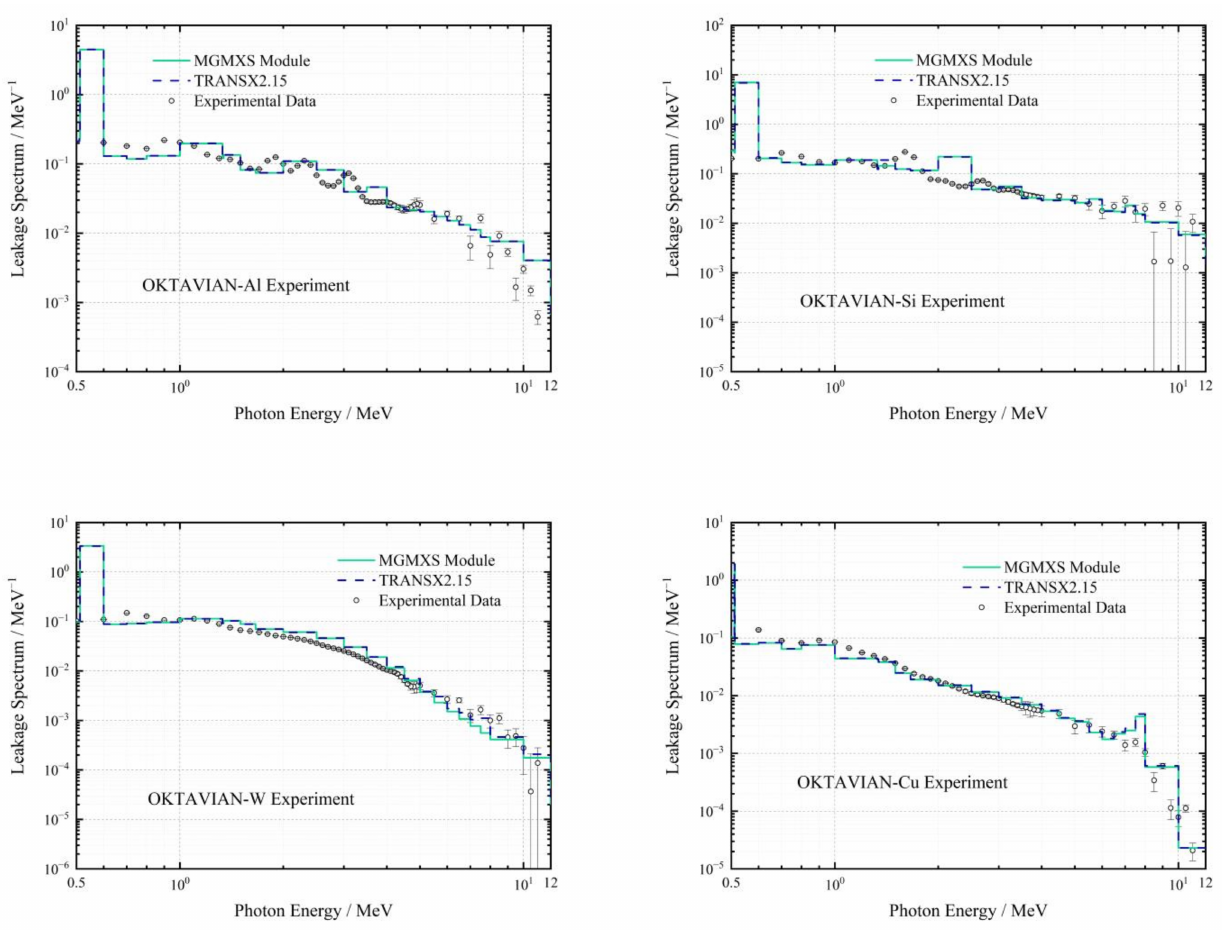
Figure 12. Comparison of experimental and calculated results of photon leakage spectrum.